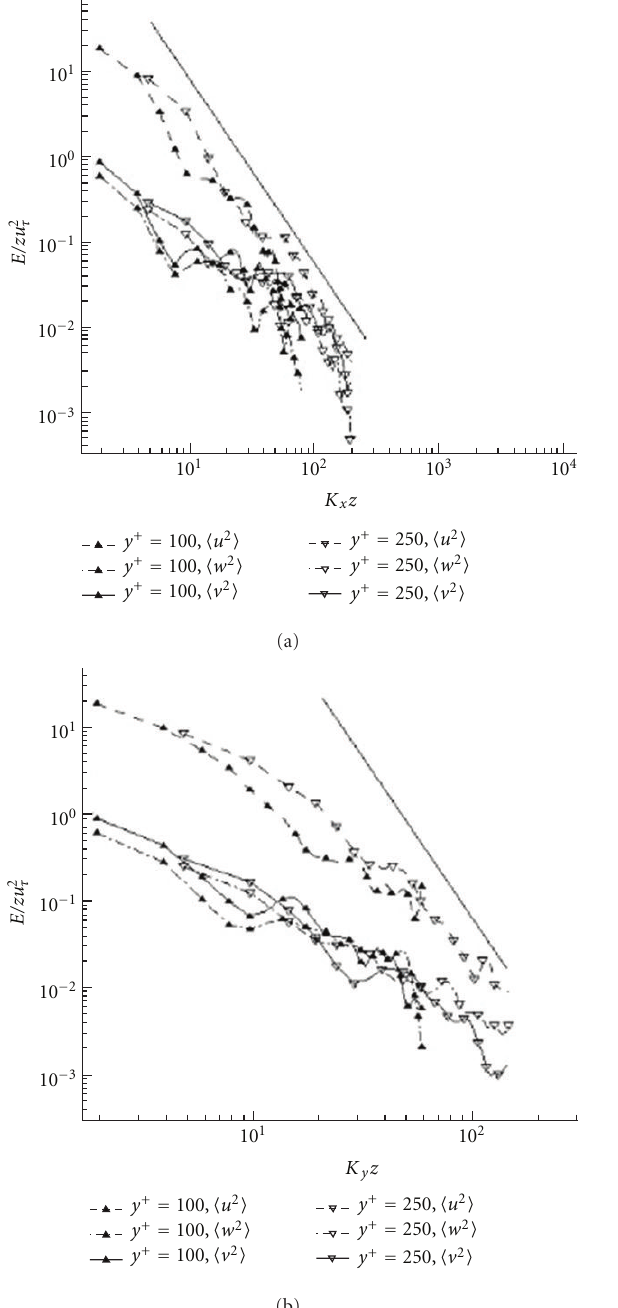
Figure 7: (a) Spectra in x -direction (b) Spectra in y -direction.